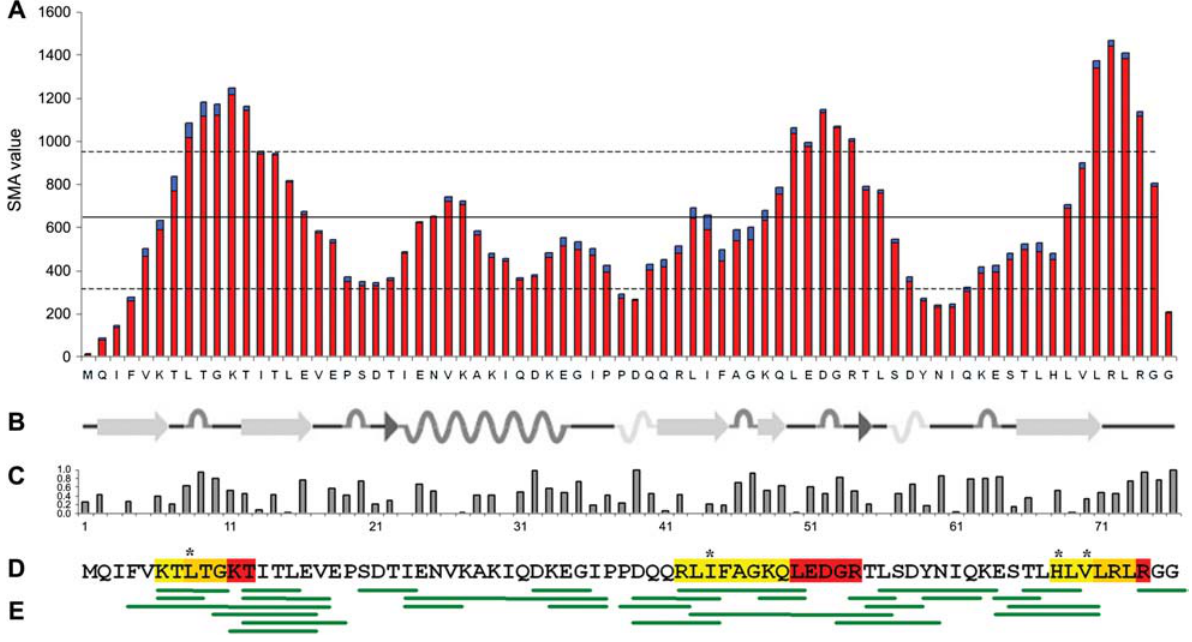
Figure 2 Comparison of the (A) overall pentapeptide queries results with (B) Ub secondary structure, (C) surface accessibility of residues, (D) specific regions of Ub responsible for non-covalent protein–protein interactions, and (E) selected short peptide motifs found through Minimotif Miner and/or ELM searches. On graph (A) blue bars indicate UbLs hits whether red bars all other protein hits. The SMA values for specific amino acids were calculated according to Eq. (1). Average SMA values are represented with solid lines, standard deviation ranges are marked with dashed lines. Fragments marked over primary structure of Ub responsible for most of the Ub interactions with receptors are given in yellow, the most frequently found in other proteins are given in red, and overlay of both in